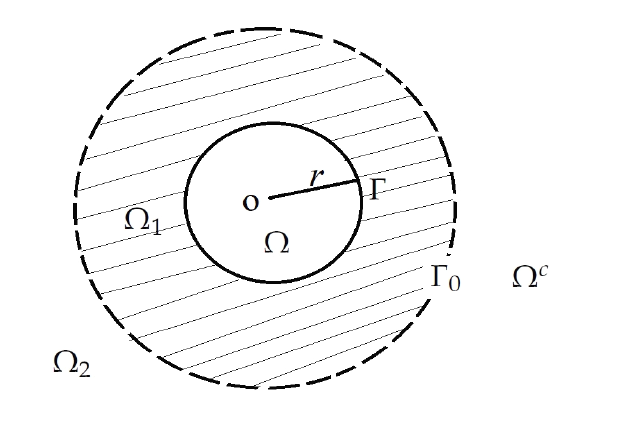
Figure 1. The inner region Ω and the outer region Ω c = R 2 \ ¯ Ω = Ω 1 ∪ ¯ Ω 2 . For given time upper limit T , we study the following initial boundary value problem of the uniform transmission line (UTL) equation in the two-dimensional (2D) boundless outer